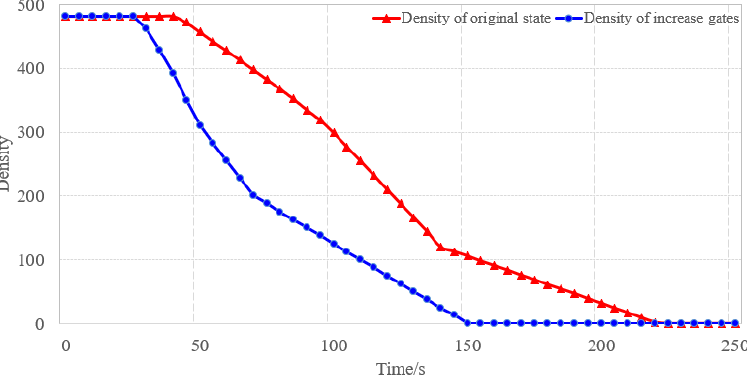
Figure 19. Original evacuation and increasing gates evacuation.